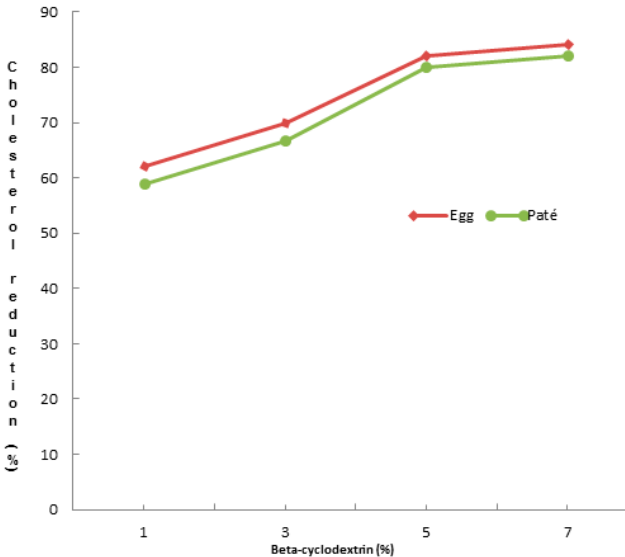
Figure 1. Effect of β -cyclodextrin ( β -CD) concentrations (1, 3, 5 and 7%) on the removal of cholesterol from egg yolk and duck liver pâté.